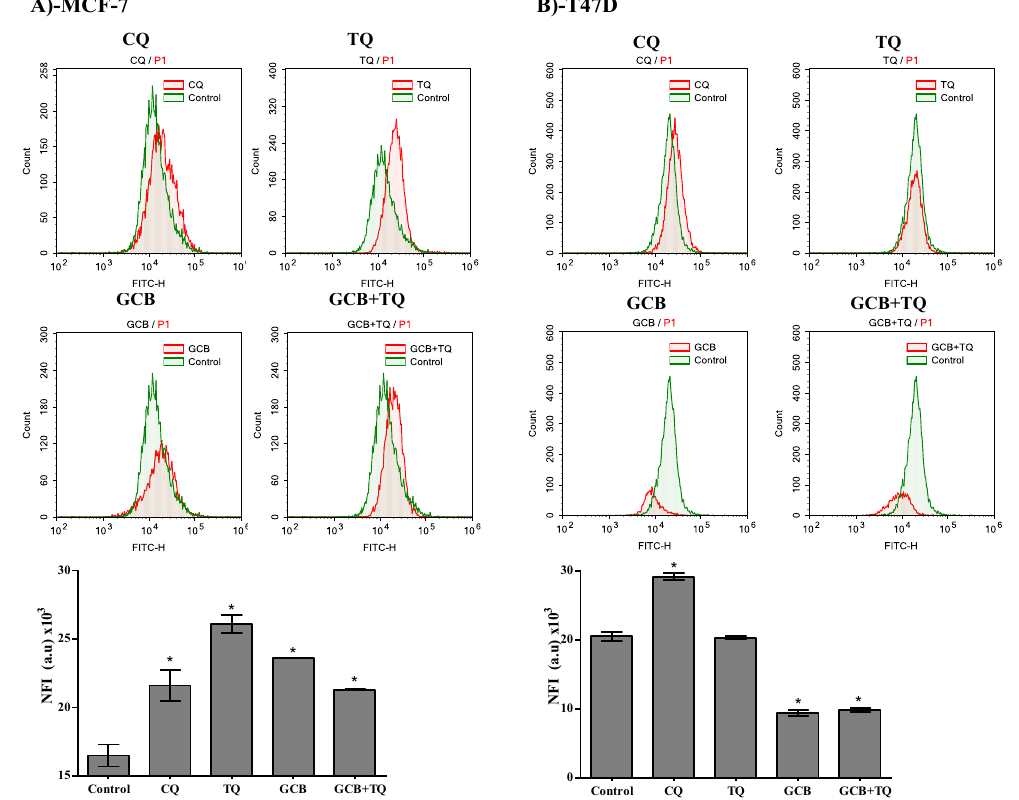
Figure 5. Autophagic cell death assessment in MCF-7 ( A ) and T47D ( B ) cells after exposure to GCB, TQ and their combination. Cells were exposed to GCB, TQ or their combination for 24 h; and were stained with Cyto-ID autophagosome tracker. Net fluorescent intensity (NFI) were plotted and compared to basal fluorescence of control group. Data is presented as mean ± SD; n = 3. * Significantly different from control group. ** Significantly different from GCB